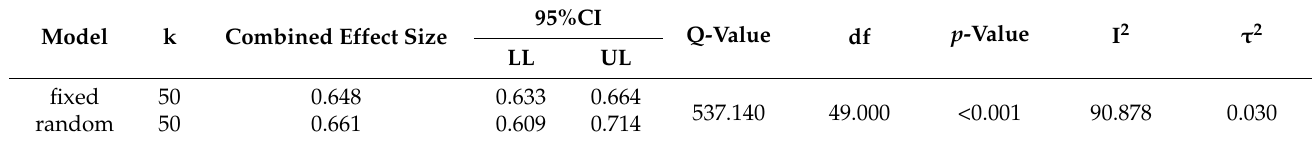
Table 3. The heterogeneity test of the whole